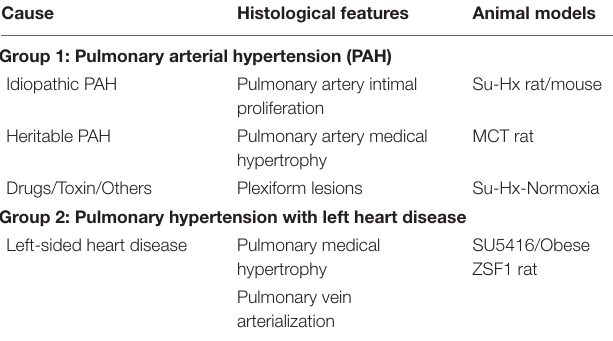
TABLE 1 | Animal models of pulmonary hypertension. Cause Histological features Animal